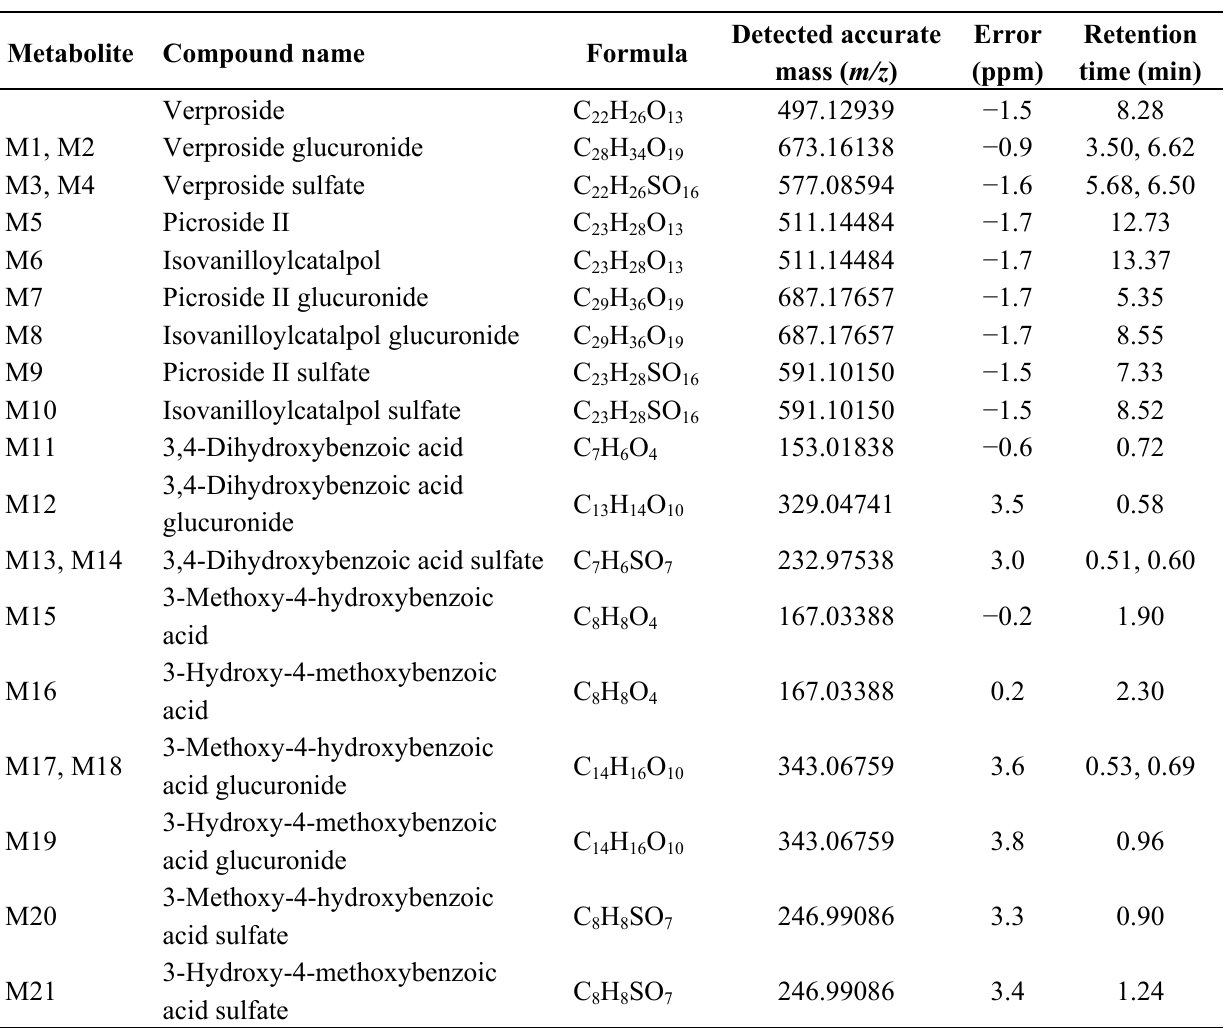
Table 1. Accurate mass and retention time of verproside and its metabolites identified in the urine and bile samples obtained after intravenous injection of verproside at a dose of 10 mg/kg in male Sprague Dawley